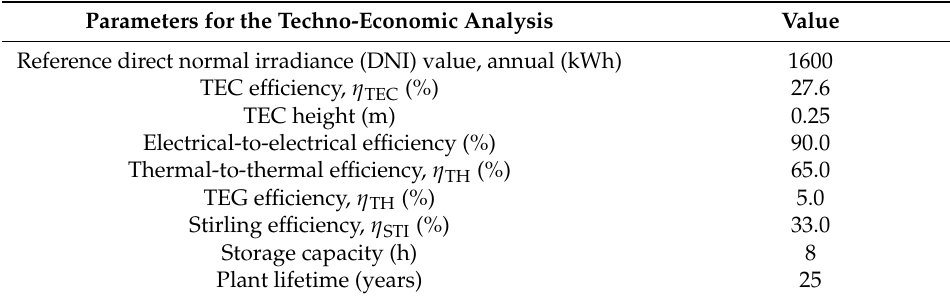
Table 4. Main parameters used for the LCoE calculations. Parameters for the Techno-Economic